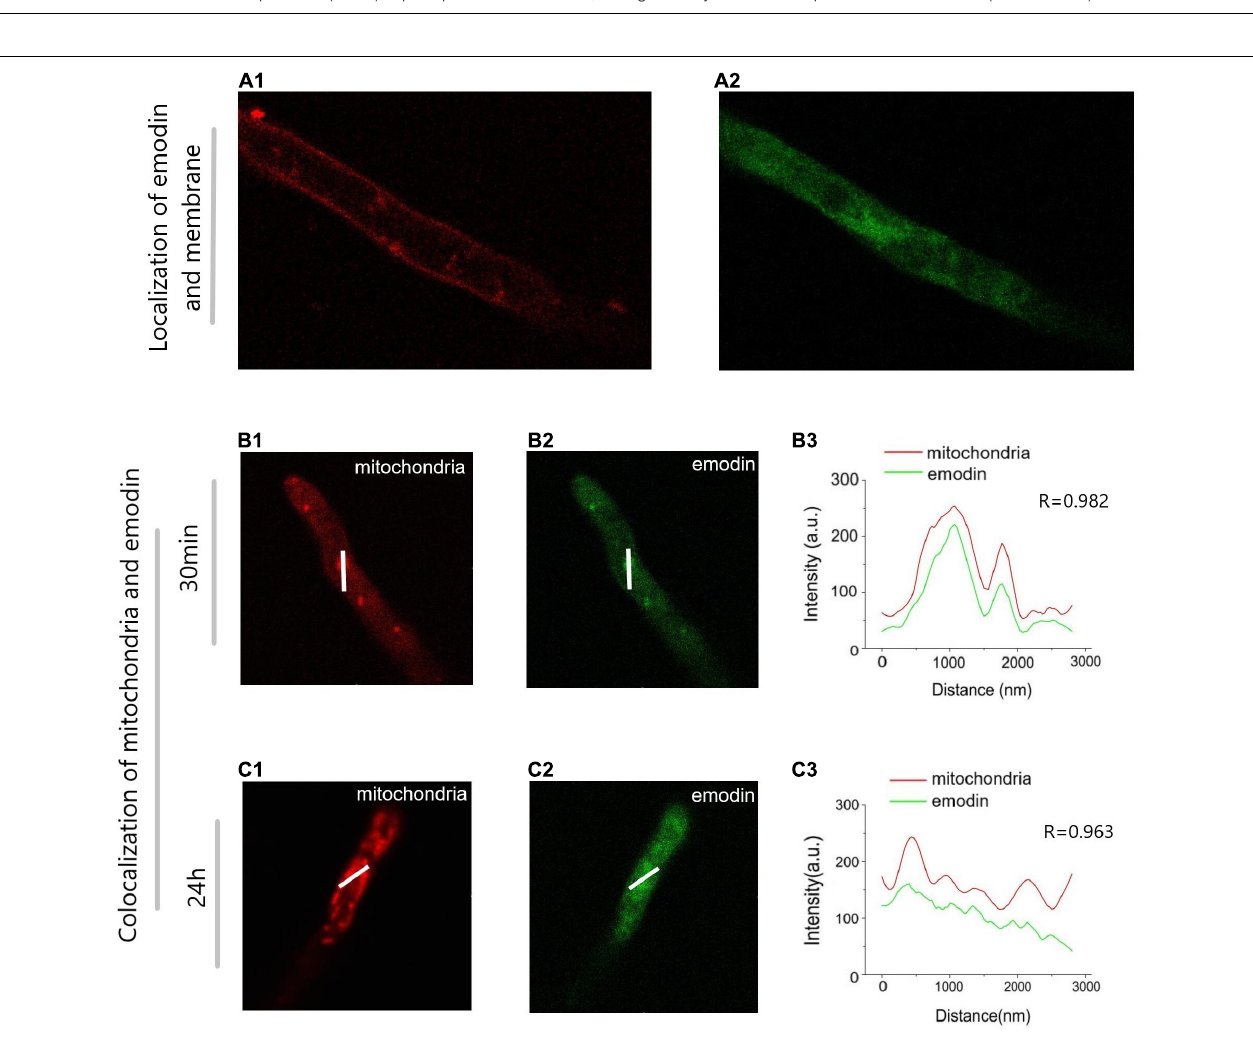
FIGURE 6 | Image of Trametes versicolor mycelium infected with emodin shot by confocal laser scanning microscope. The image displays the position of cytomembrane (A1) and the fluorescence intensity of emodin Inside the mycelium (A2) . It reveals the location of mitochondriais (B1) and emodin (B2) after 30 min of incubation, the position of mitochondriais (C1) and emodin (C2) after 24 h and the Intensity profile plot along the selected lines (B,C) in images (B3,C3) . Emodin has autofluorescence, which the concentration in suspension is 0.5 µ mol/mL, cytomembrane and mitochondria are, respectively, stained with Mito Tracker Deep Red and Cell Mask Deep Red for 1 µ